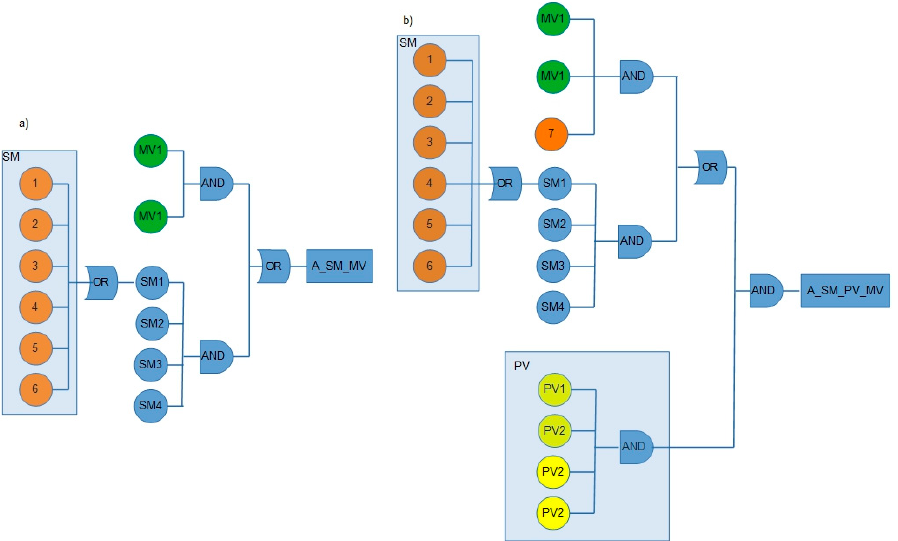
Figure 9. The logic diagrams of proposed power supply system reliability ( a ) SM connected to medium voltage line, ( b ) supplying modules connected to MV line and photovoltaic sources. The failure rates of single SMs elements are assumed as follows: 1—failure of AC/DC converter for battery charging, 2—failure of step-down transformer for battery charging, 3—failure of lithium-ion battery, 4—failure of DC/DC converter of track 1,5—failure of DC/DC converter of track 2,6—discharge of lithium-ion battery as a result of failure of energy management strategy, and 7—failure of photovoltaic source (panel or DC/DC converter). The failure of MV line sources, or failure of the very line are marked as MV1 and MV2 (failure of MV line at the first half of the line length is contained in the parameter MV1 and in the second half of the length—in MV2).